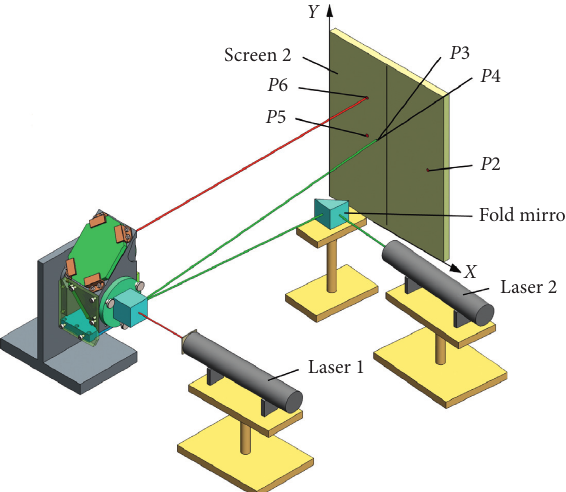
Figure 11: Adjustment of the TSM (Step 2)